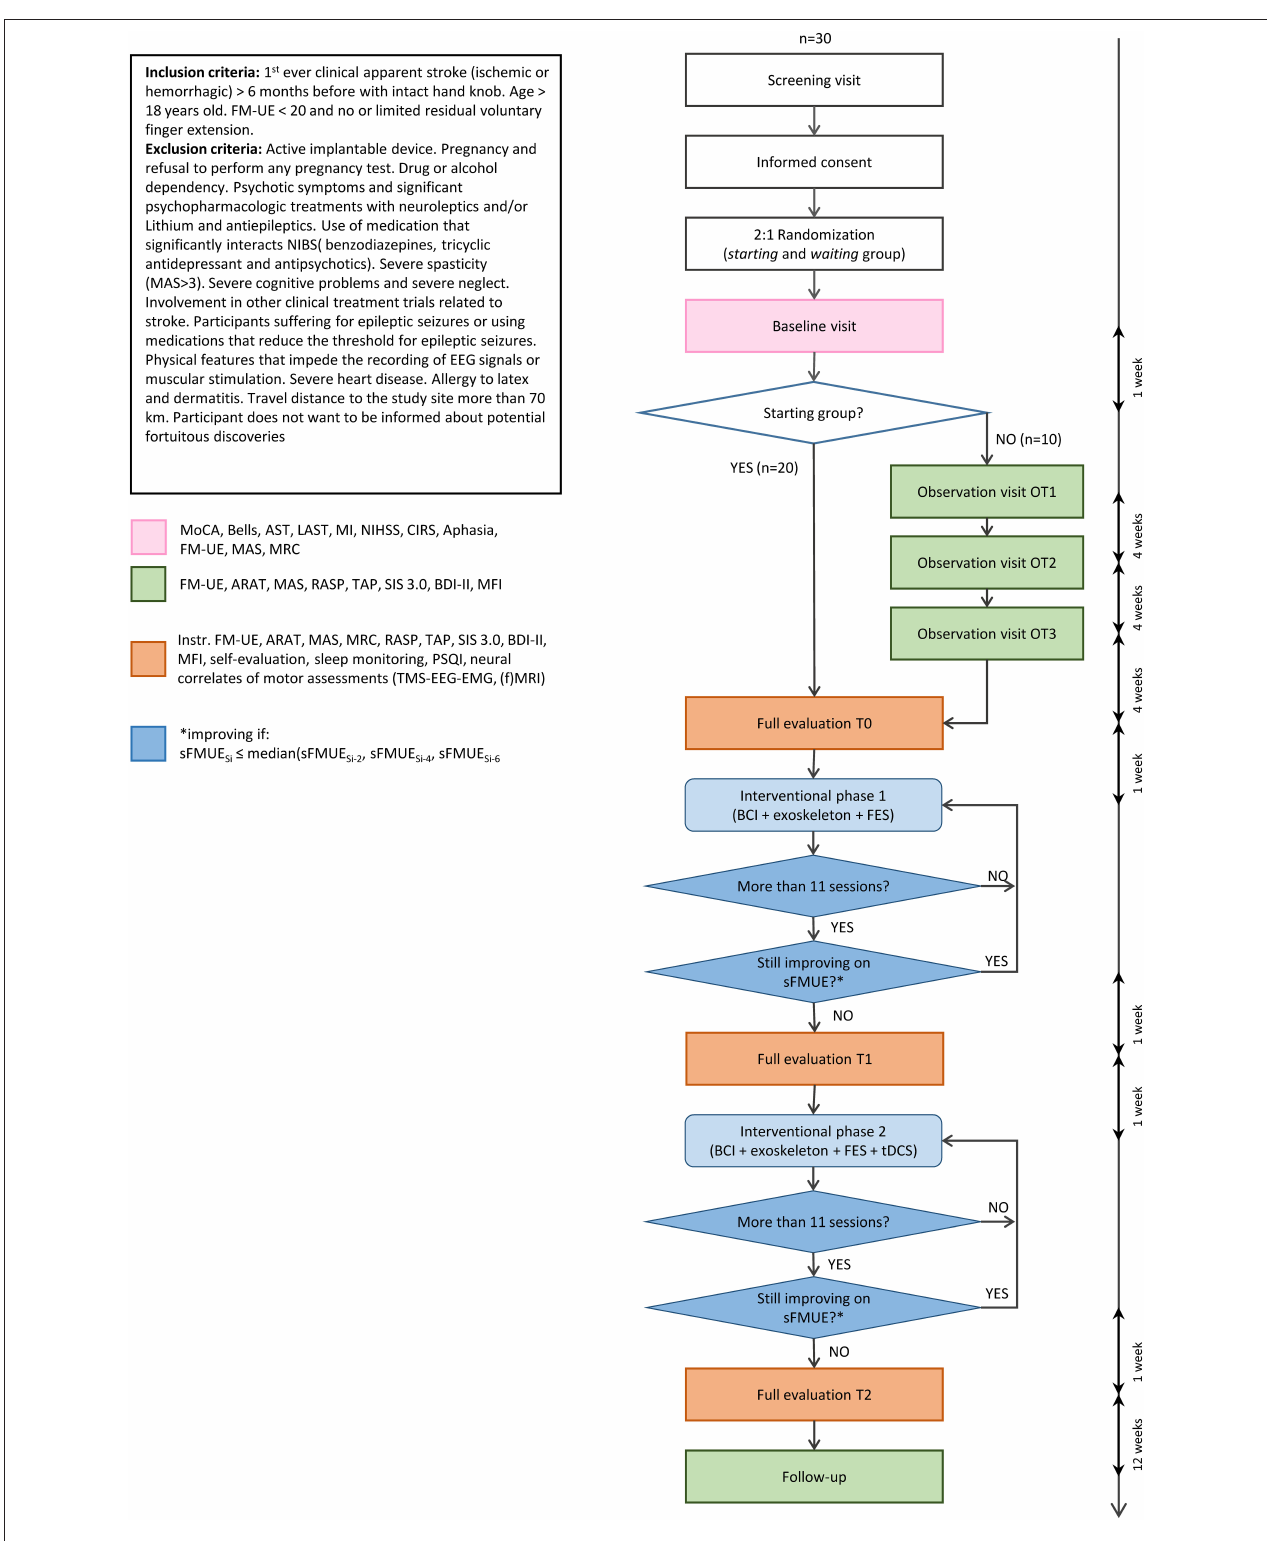
FIGURE 1 | Flowchart of the AVANCER study with patient inclusion/exclusion criteria. The procedure flow shows the timeline with maximum delays between steps in terms of weeks. MoCA, Montreal Cognitive Assessment (36); Bells, Bells cancellation test (37); AST, apraxia screening of TULIA (38); LAST, language screening